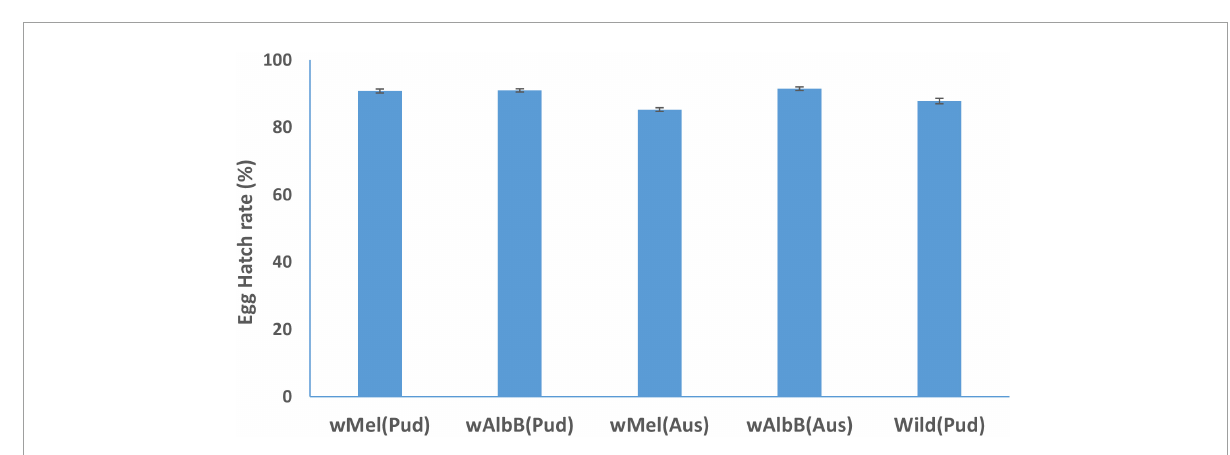
FIGURE2 Hatch rate ( ± SE) of eggs of Wolbachia -infected Ae. aegypti females and uninfected wild Ae. aegypti (Pud)